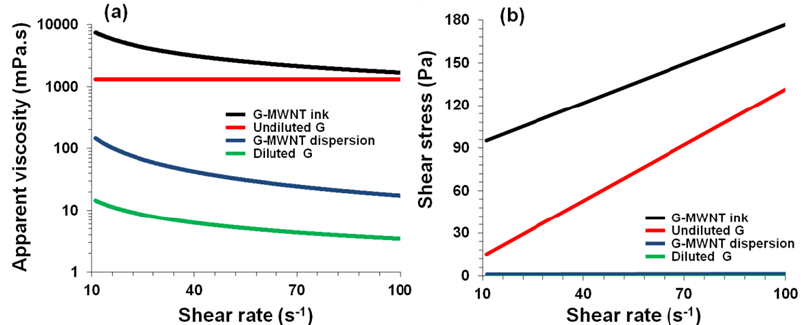
Figure 2. Flow curves for glycerin and G-MWNT dispersions. ( a ) Apparent viscosity and ( b ) Shear stress as a function of shear rate for G-MWNT ink after thickening process, undiluted glycerin, G-MWNT dispersion and diluted glycerin. Lines in ( a , b ) are fits to Equations (1) and (2), respectively. All samples were measured at 21 ◦